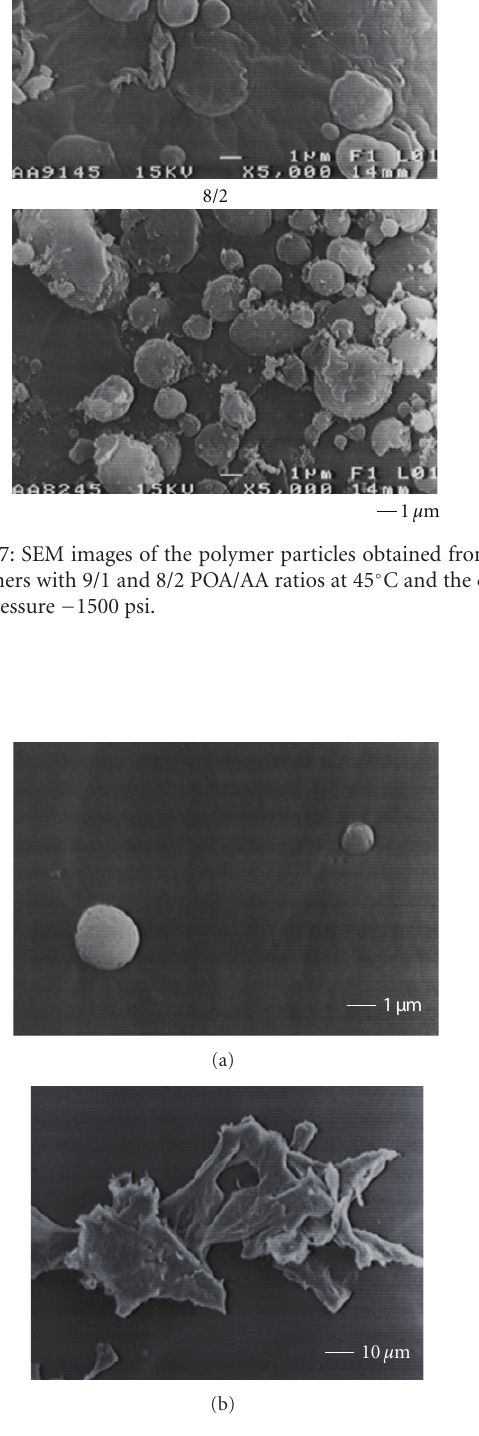
Figure 10: Plots of the cloud points of the copolymer with 7/3 of POA/DAA in the presence of PA at 0.3 and 0.5 of